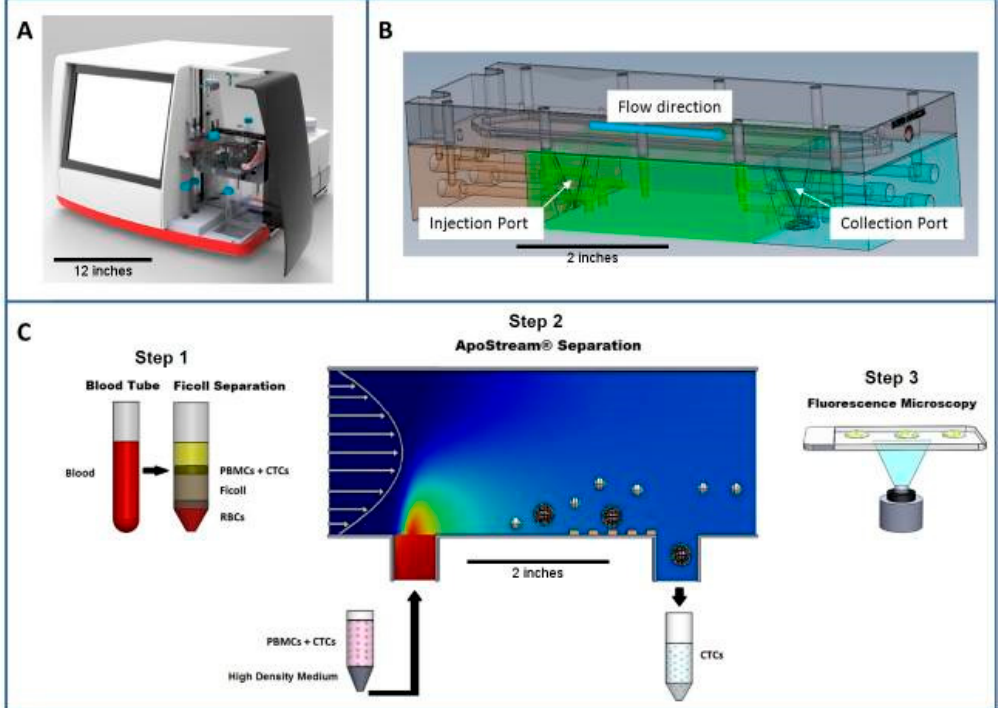
Figure 11. Photography and illustration of the ApoStream ® instrument. ( A ) The ApoStream ® prototype instrument. ( B ) Illustration of the flow chamber showing V-shaped injection and collection ports. ( C ) Step 1: Sample processing by Ficoll density gradient separation to isolate blood cells and CTCs. Step 2: Dielectrophoresis (DEP) enrichment starting with sample injection, ion diffusion, DEP